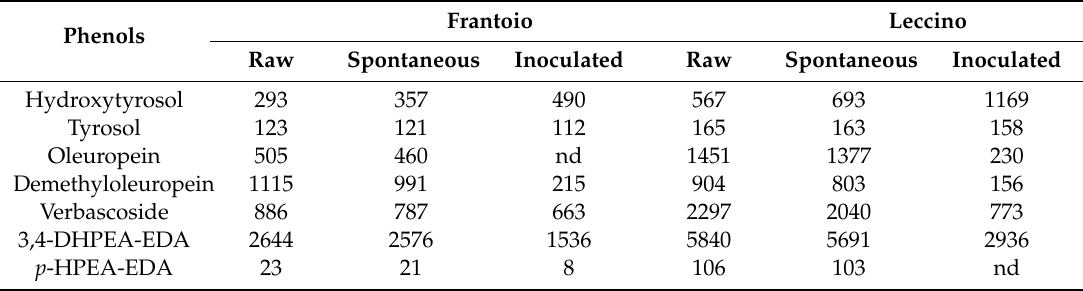
Table 1. E ff ect of spontaneous and inoculated fermentation on phenolic composition of table olives. Data are expressed as mg / kg of pulp dry weigh. From Servili et al. [60].